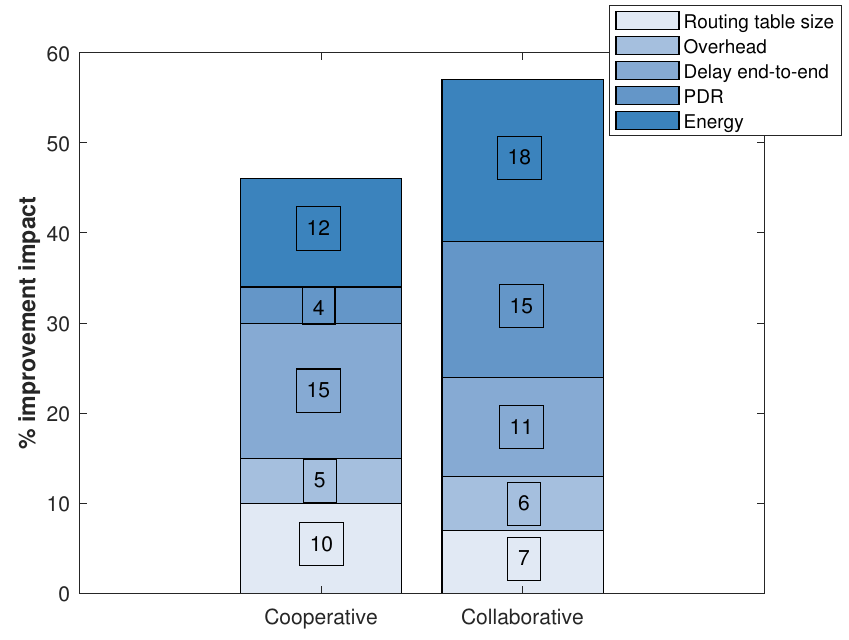
Figure 2. Percentage of improvement impact on network performance metrics.